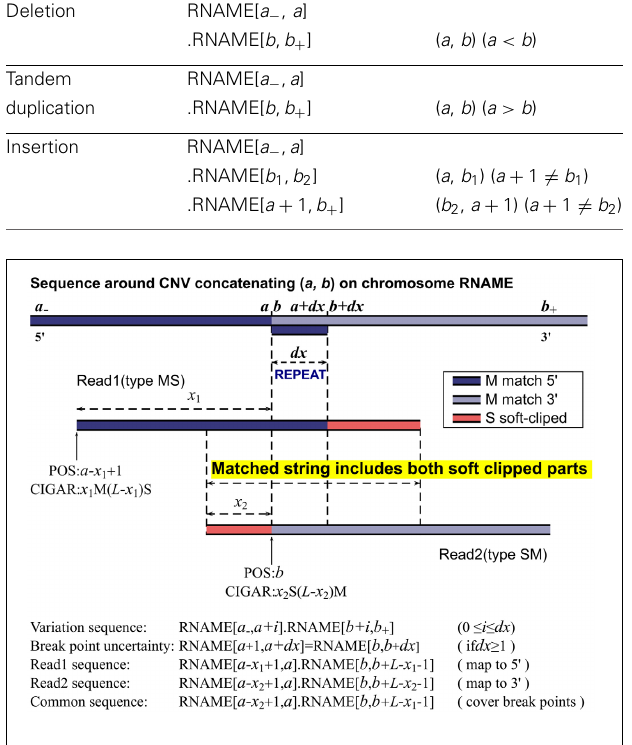
FIGURE 1 | MATCHCLIP